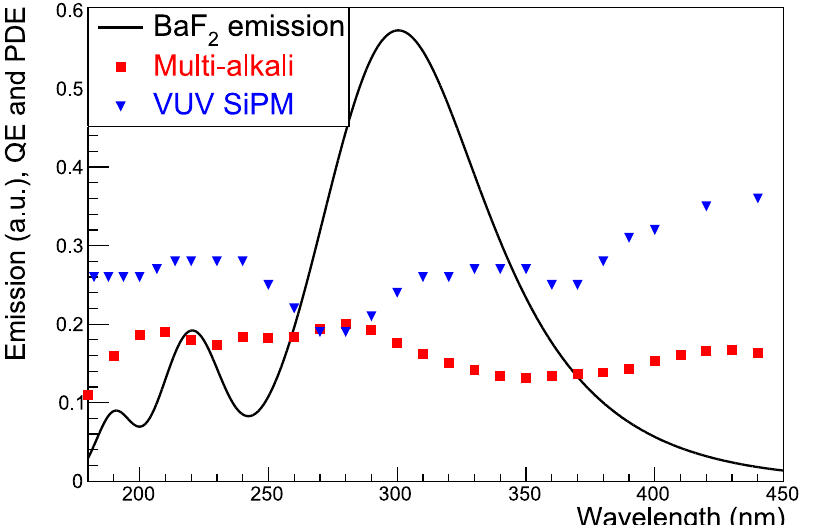
Figure 7: Spectra of BaF emission, PDE of VUV SiPM, and QE of multi-alkali photocathode modeled in this study. Additionally, an ideal photodetector, 2 the QE of which is 100% over the entire wavelength, is modeled. These spectra were used for the analytical CTR simulations.